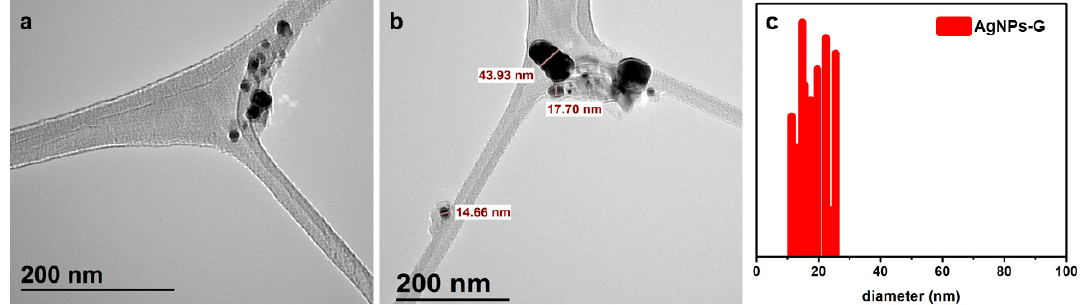
Figure 5. ( a , b ) TEM images of the green synthesized AgNPs-G using the aqueous extract of bee